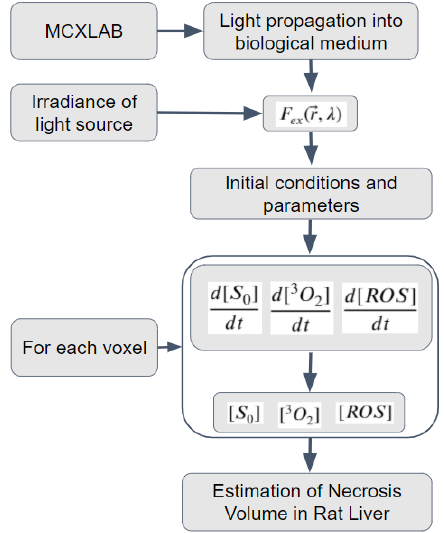
Figure 1. Schematic pathway for estimating the necrosis volume by first estimating the light fluence rate with the Monte Carlo simulation and second solving the couple differential equations of PDT. The initial concentrations of PS and oxygen were considered homogeneous inside the simulated